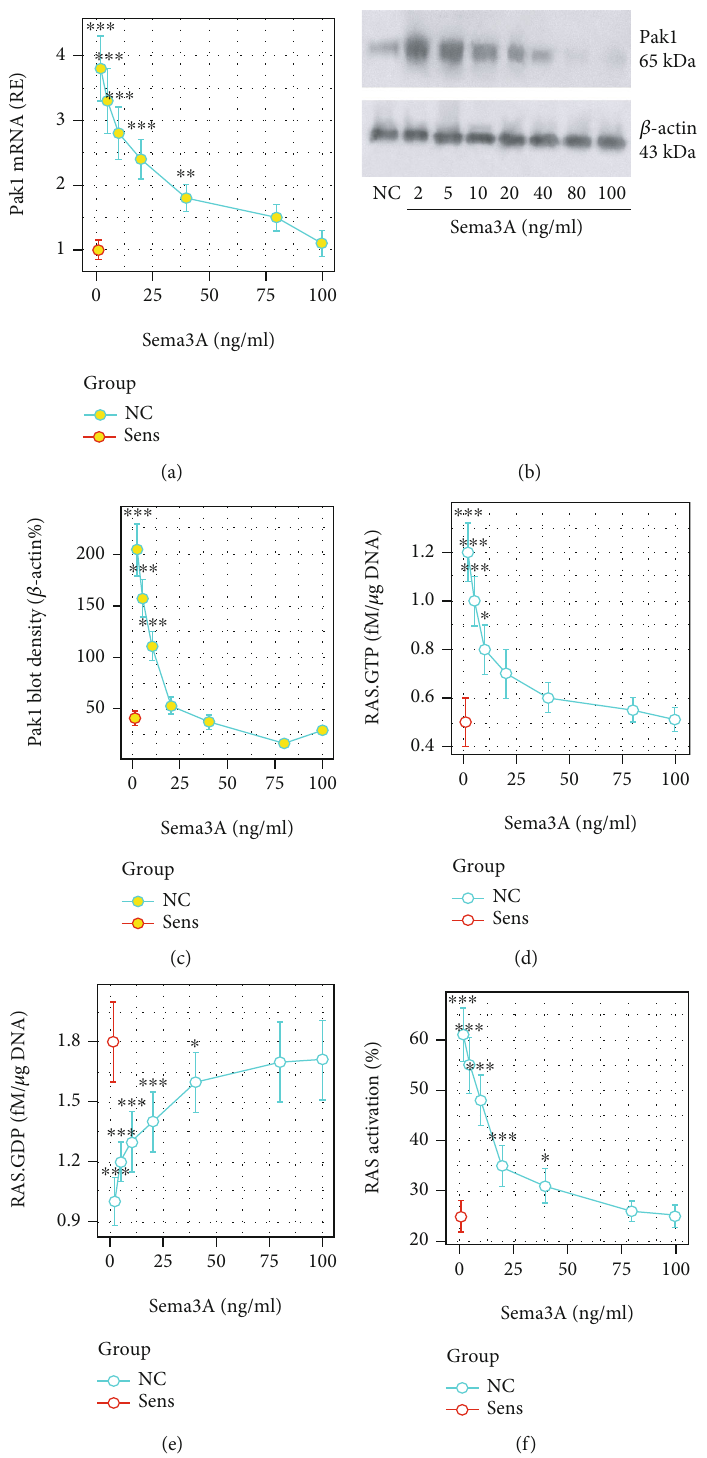
Figure 4: sema3A modulates Pak1 and RAS activities in sensitized mast cells. BMMCs were sensitized by incubating with anti-OVA-IgE (5 μ g/ml) overnight with or without the presence of sema3A at indicated concentrations. Cells were analyzed via RT-qPCR and RAS- speci fi c ELISA. (a) mRNA levels of Pak1 in BMMCs. (b, c) Immunoblots show Pak1 protein levels in BMMCs. Curves show integrated density of immunoblots of Pak1. (d – f) Curves show levels of RAS.GTP (d), RAS.GDP (e), and RAS activation (f) in BMMCs. The data are presented as mean ± SD . ∗ p < 0 : 05 , ∗∗ p < 0 : 01 , ∗∗∗ p < 0 : 001 (ANOVA+Dunnett ’ s test), compared with the NC (naïve control) group. The data represent 3 independent